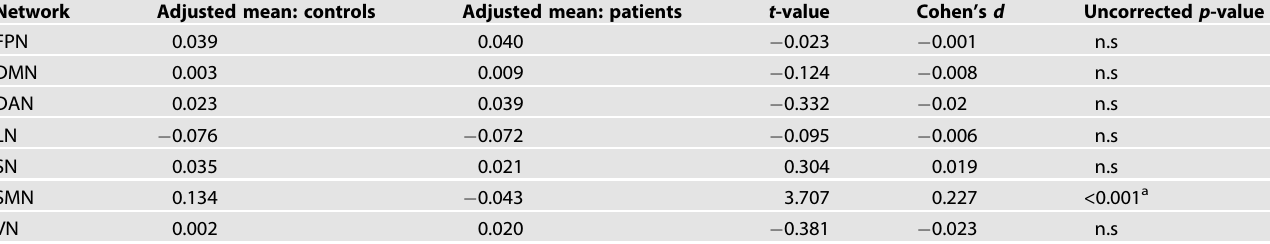
Table 3. Group differences in segregation metrics of each cortical network. Network Adjusted mean: